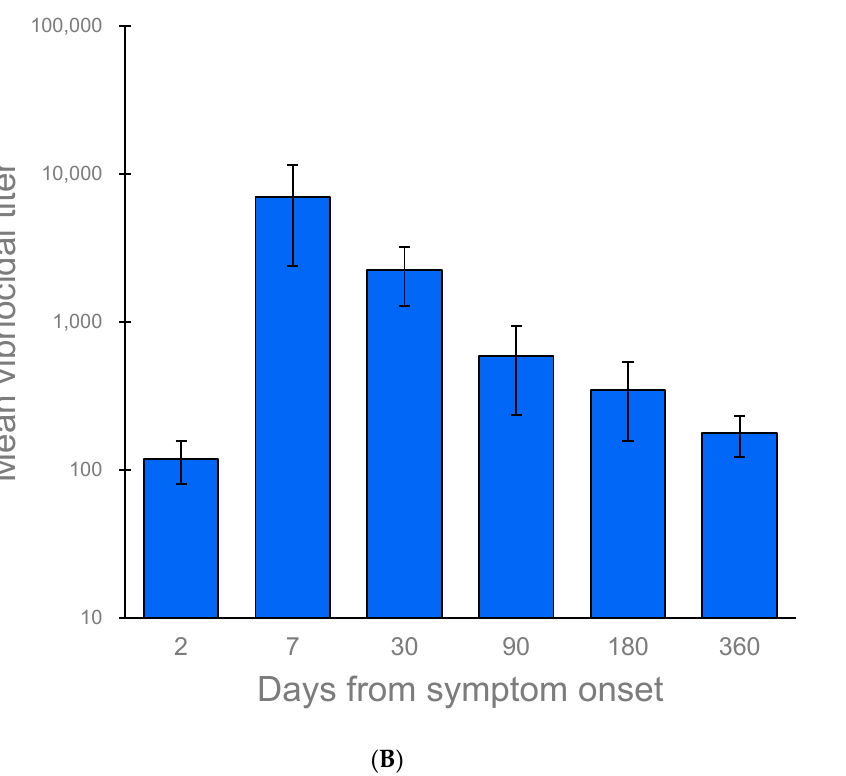
Figure 1. ( A ) Forest plots of the kinetics of vibriocidal antibody titers after cholera [37,39,40,42,43]. ( B ) Kinetics of vibriocidal antibody titers after cholera. Table 1. Kinetics of vibriocidal antibody responses following cholera.